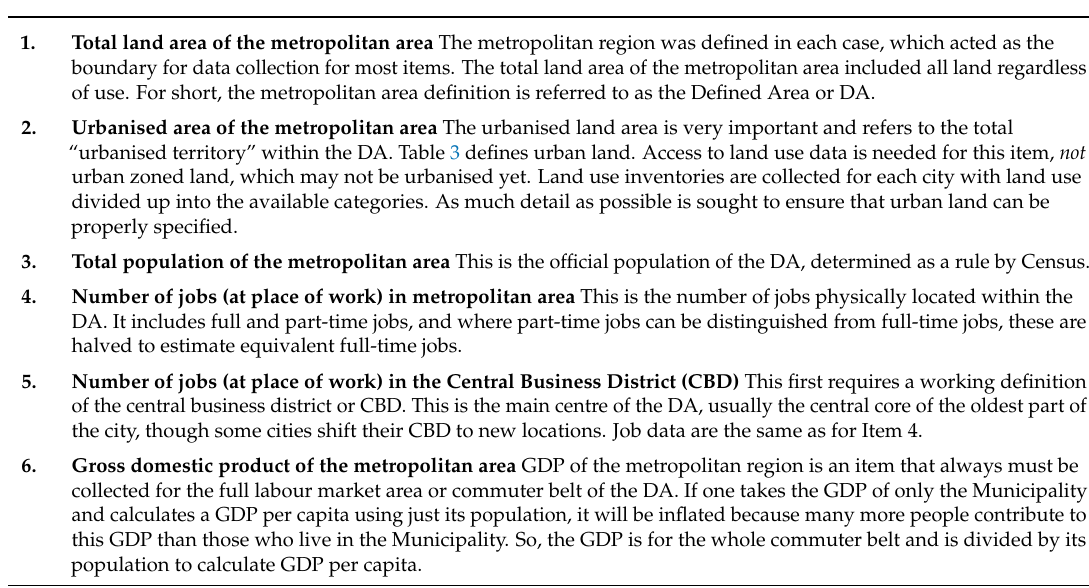
Table 2. Detailed description of the primary data variables collected for Swedish